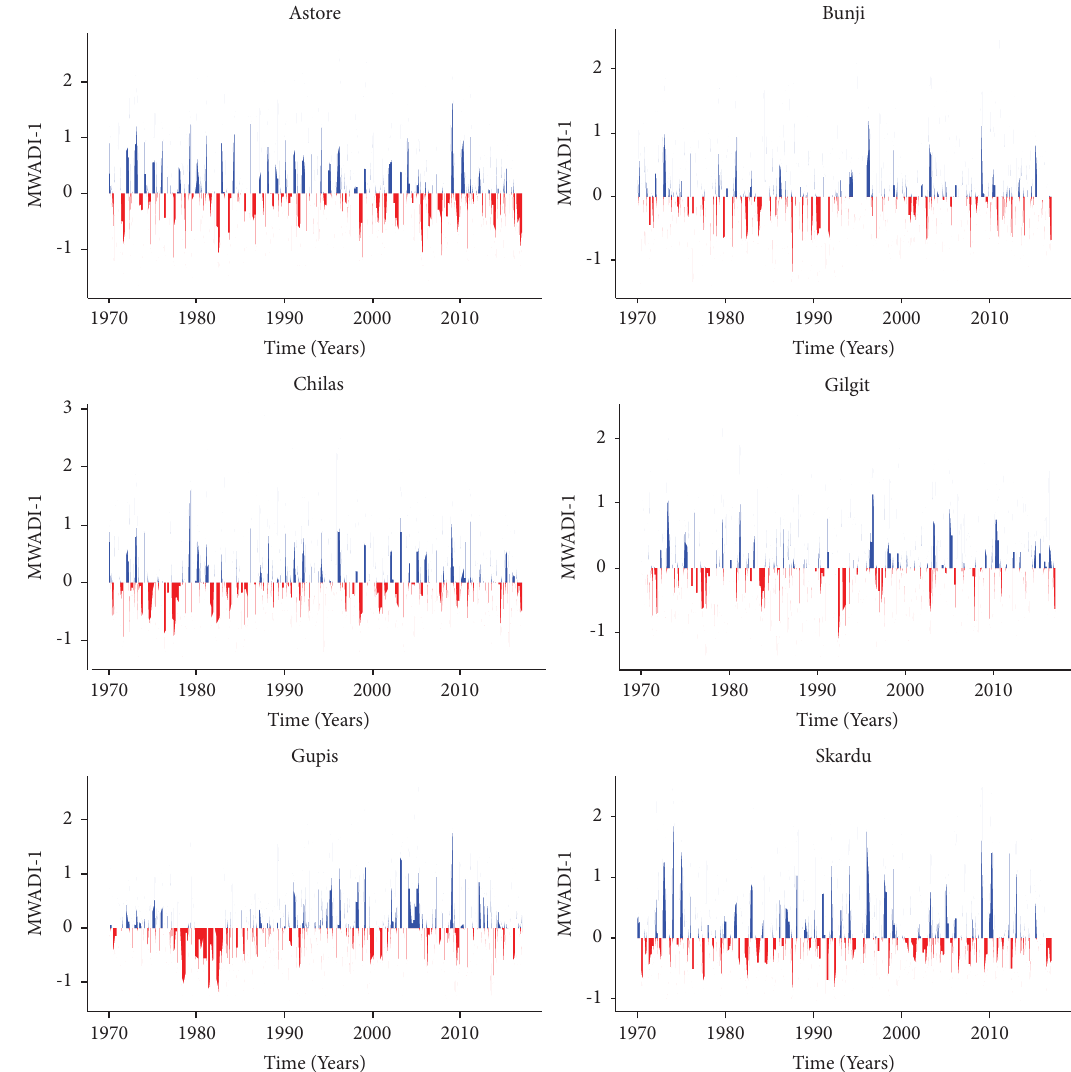
Figure 10: Temporal behavior of the MWADI at one-month time scale at all